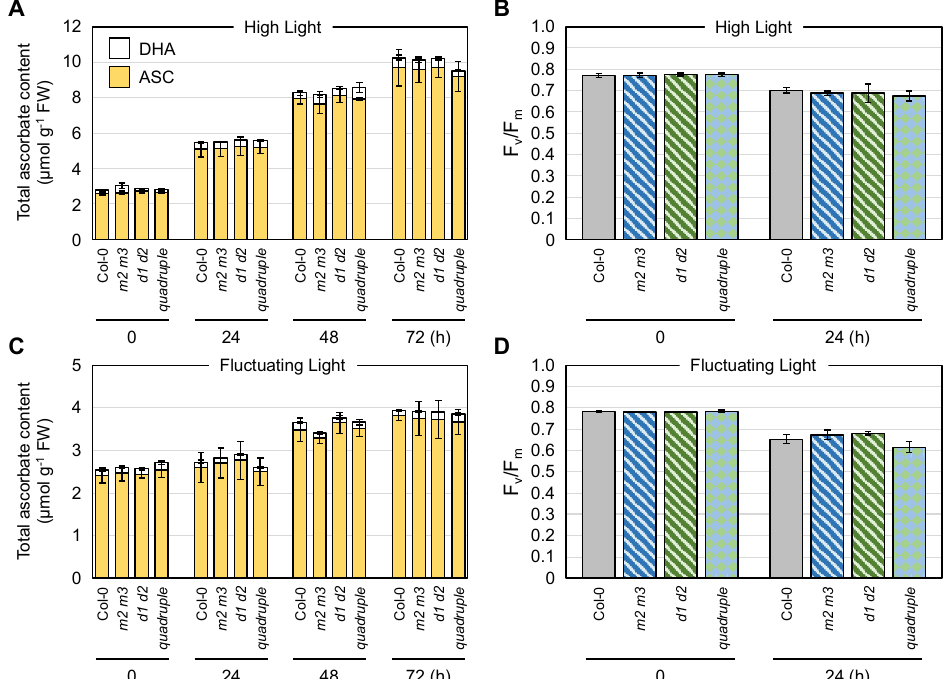
Figure 9. The combined impacts of cytosolic MDARs and DHARs on the foliar ascorbate profile under light stress conditions. Arabidopsis thaliana wild-type (Col-0), mdar2-1 mdar3-1 ( m2 m3 ), dhar1- 1 dhar2-1 ( d1 d2 ), and mdar2-1 mdar3-1 dhar1-1 dhar2-1 (quadruple mutant) plants were grown in soil under normal light (100 µmol photons m −2 s −1 ) conditions for 25 days and then exposed to ( A , B ) high light (1500 µmol photons m −2 s −1 ) or ( C , D ) fluctuating light (see Materials and Methods) for 72 h. ( A , C ) The total ascorbate content (the sum of the reduced and oxidized forms) in the leaves was measured. The ascorbate redox state (the ratio of the reduced form to the total content) is shown in Table S3. ( B , D ) The maximum quantum yield of photosystem II (F v /F m ) was measured before and after stress. Data are presented as the mean ± SE of at least three biological replicates. There were no significant differences in the ascorbate profiles and F v /F m values among the genotypes at any time (Tukey–Kramer test). ASC, reduced ascorbate; DHA, dehydroascorbate (oxidized form).